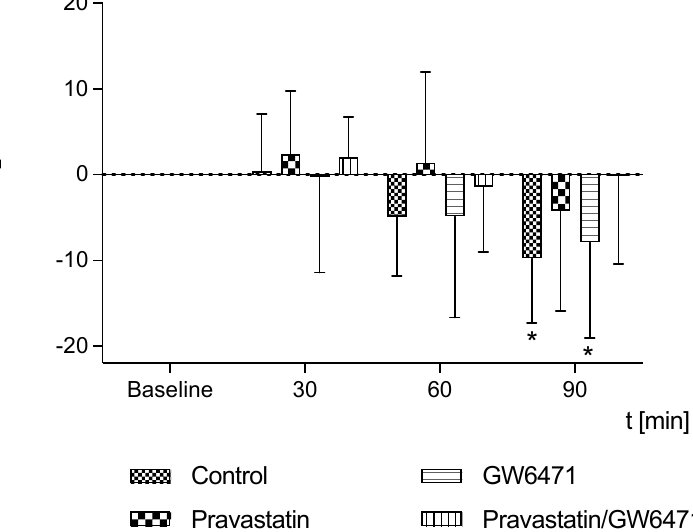
Figure 2. Postcapillary oxygenation of the liver ( µ HbO 2 ) was measured in untreated septic animals (control) and after treatment with pravastatin, PPAR- α -antagonist GW6471, pravastatin and GW6471. Data are presented as absolute percentage points with regard to baseline values and shown as mean + SD, n = 10, * p < 0.05 vs. baseline.